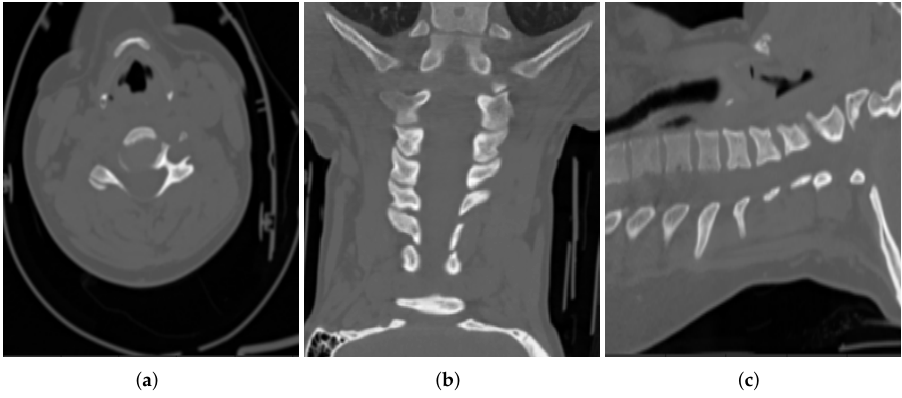
Figure 2. Sample CT images from ( a ) Axial, ( b ) Coronal and ( c ) Sagittal views for a